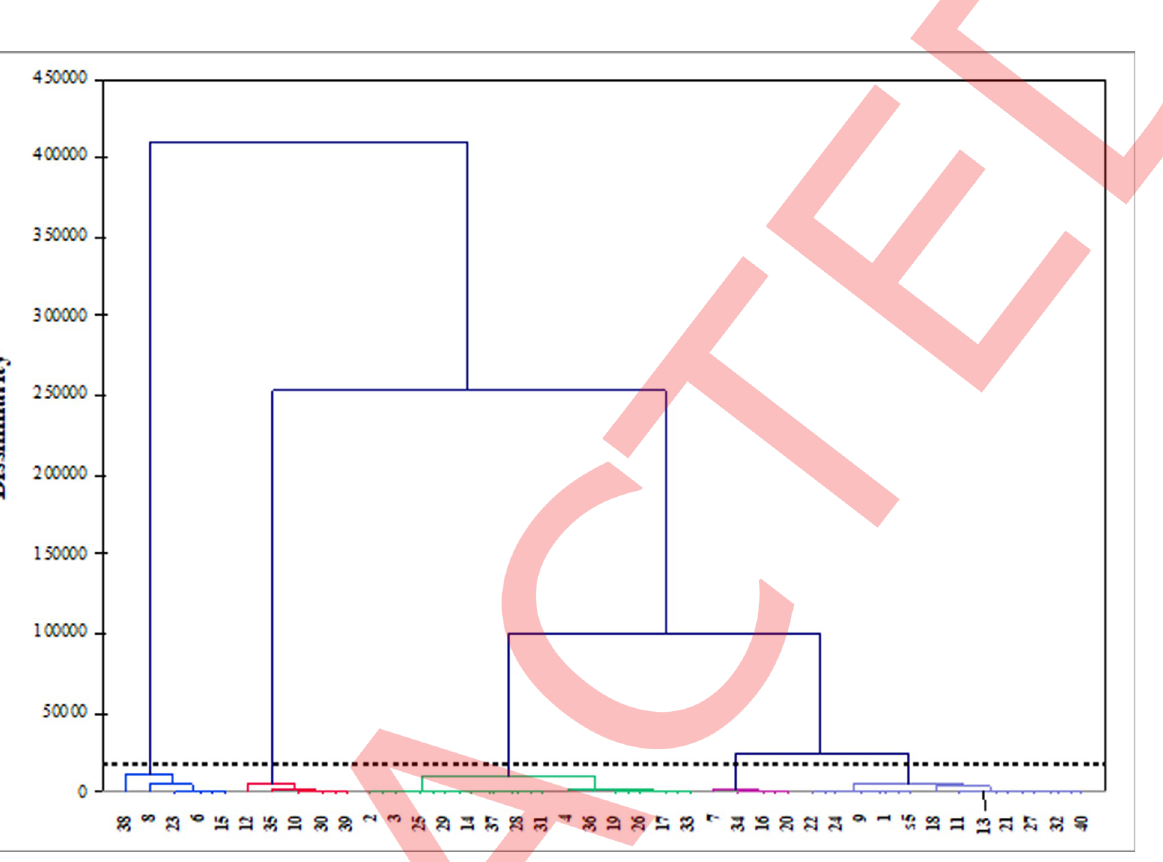
Fig 2. Dendrogram resulting from the cluster analysis executed on different growth and yield-related traits of forty different wheat genotypes included in the study. The genotype codes are given in Table 1.